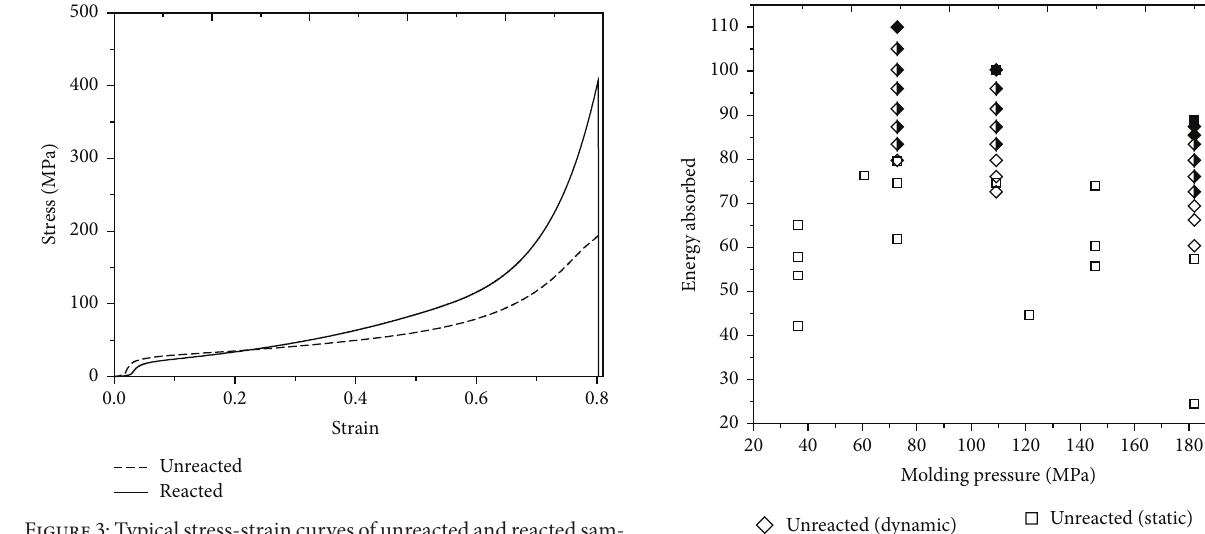
Figure 3: Typical stress-strain curves of unreacted and reacted sam- ples, where stress and strain are engineering stress and engineering strain. Al-PTFE under quasi-static compression, which shows that reacted sample has higher toughness (the area under the stress- strain curve) than the unreacted one. Figure 4: Energy absorption for Al-PTFE under quasi-static and